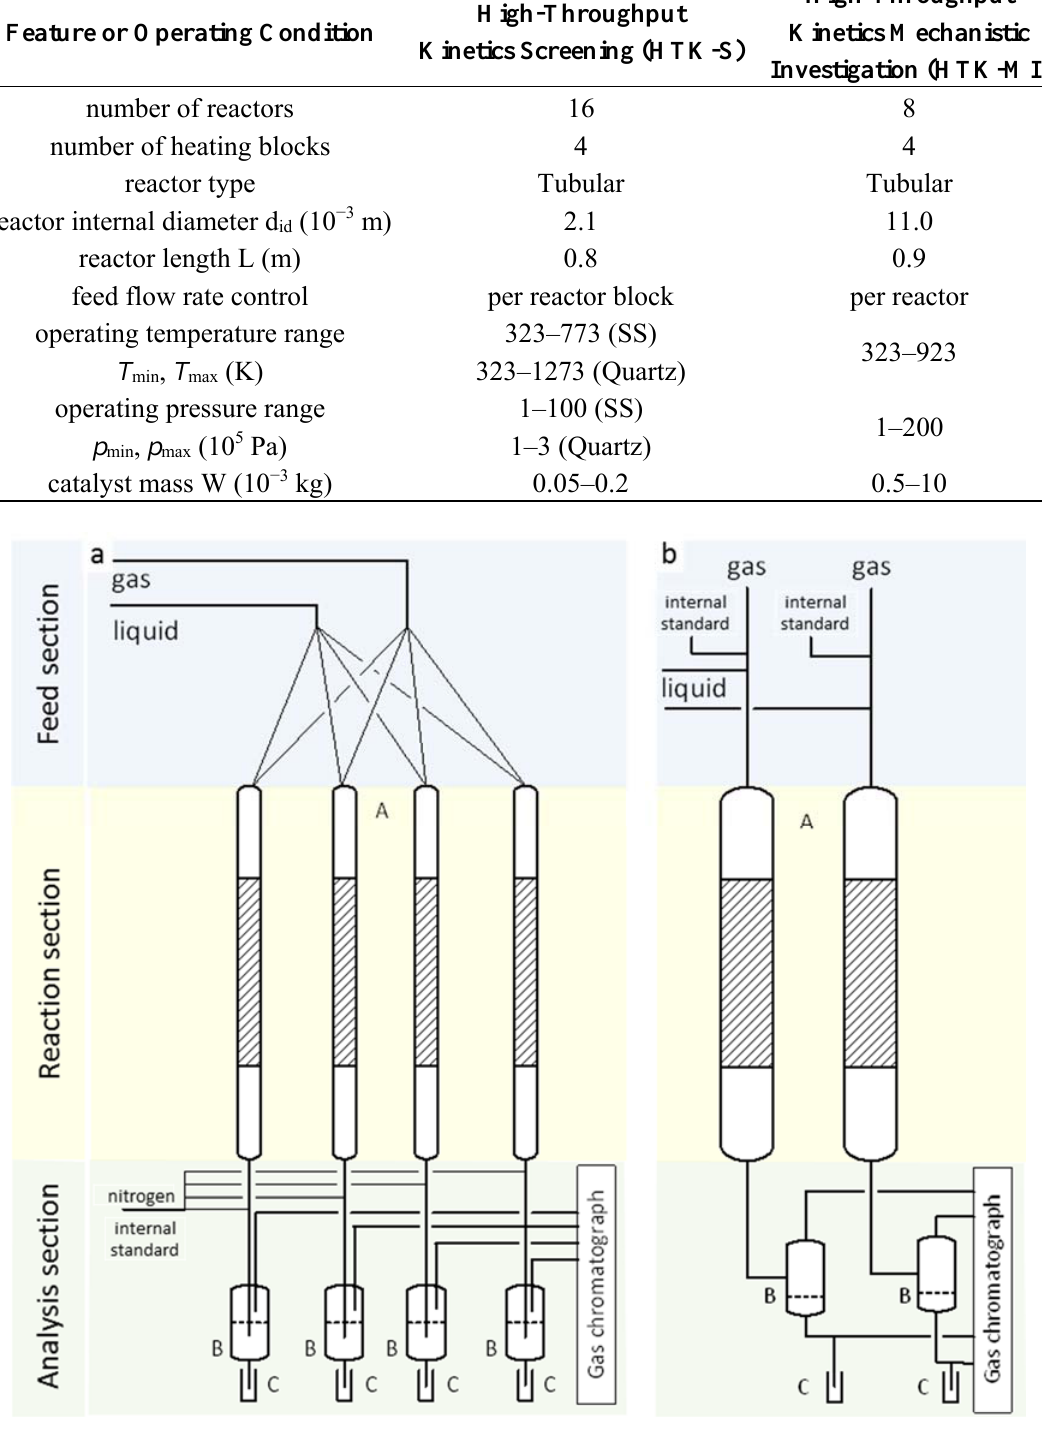
Figure 2. Schematic representation of one reactor block highlighting the differences between ( a ) HTK-S and ( b ) HTK-MI, where A corresponds to the reactors, B to the gas/liquid separators and C the liquid waste